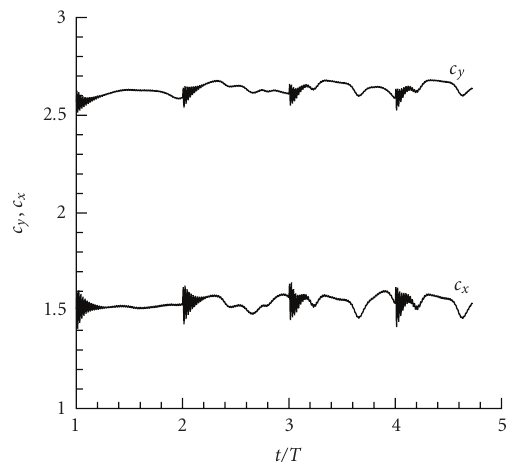
Figure 9: Lift and drag coe ffi cients for the LCL model for the peri- odically disturbed flow.